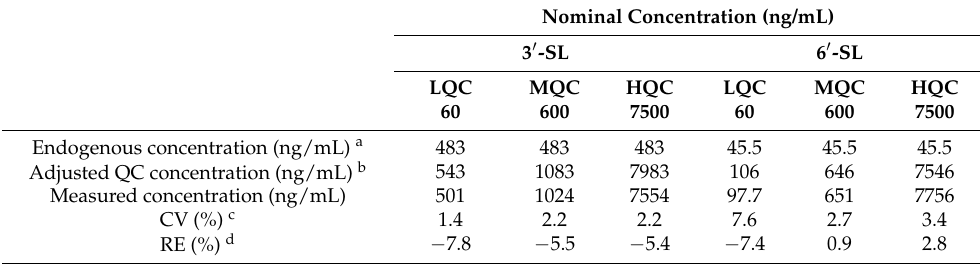
Table 4. Parallelism between authentic matrix and surrogate